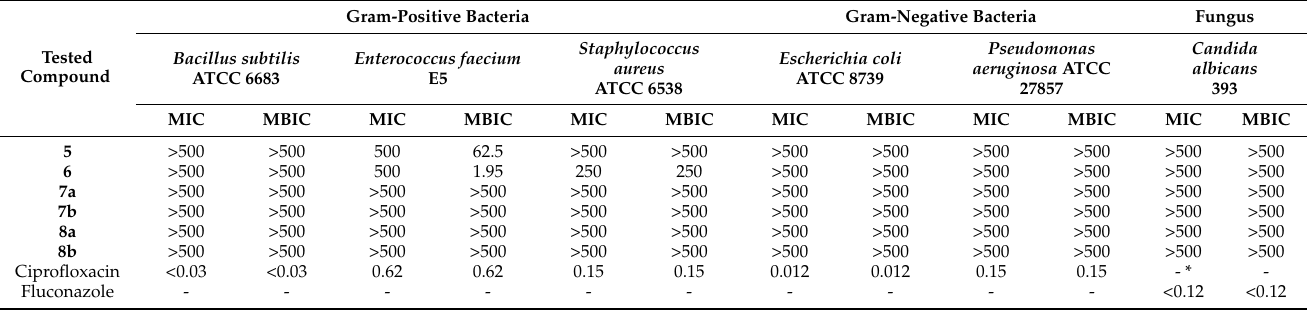
Table 5. MIC (minimal inhibitory concentration) and MBIC (minimal biofilm inhibitory concentra- tion) values in µ g/mL determined for compounds 5 – 8 tested at concentrations between 500 and 0.97 µ